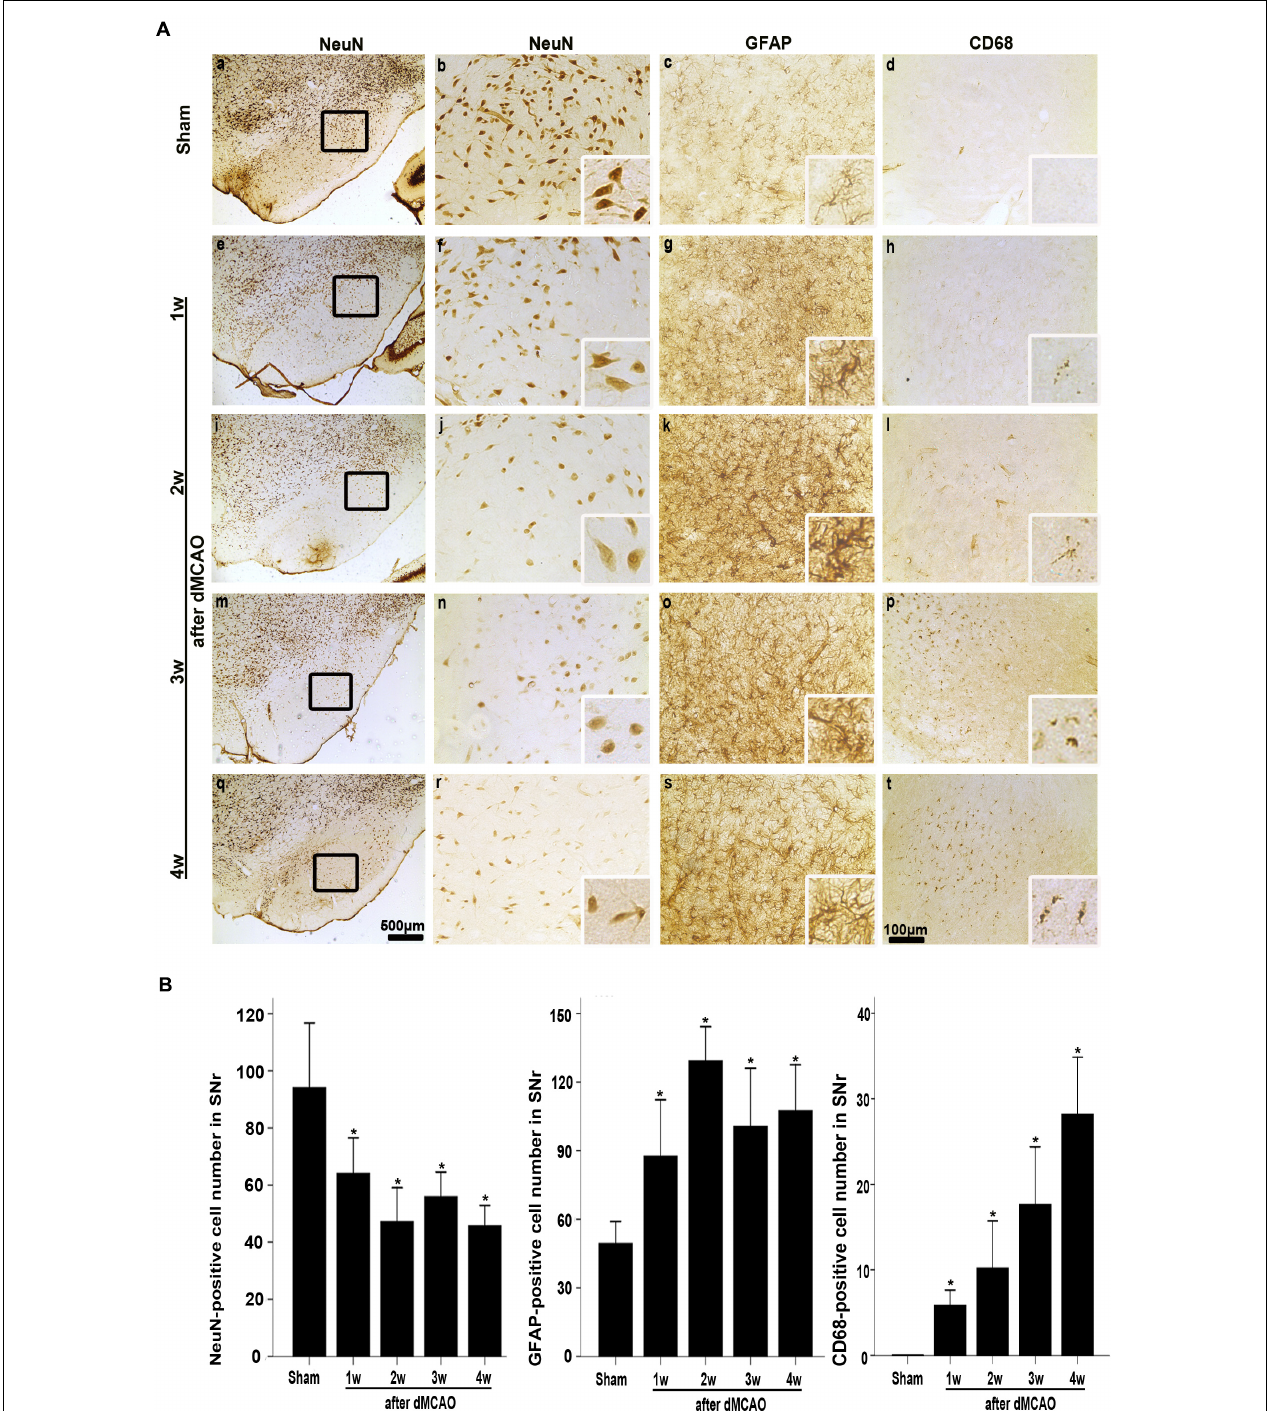
FIGURE 3 | Secondary degeneration in the ipsilateral SNr after dMCAO in rats. (A) Representative microphotographs of immunostaining of NeuN, GFAP, and CD68 in the ipsilateral SNr at 1–4 weeks after dMCAO or sham operation. a–d , sham-operated group; e–h , 1 week after dMCAO; i–l , 2 weeks after dMCAO; m–p , 3 weeks after dMCAO; q–t , 4 weeks after dMCAO; Scale bar: b–d , f–h , j–l , n–p , r–t : 100 µ m; a , e , i , m , q : 500 µ m. (B) Quantitative analysis of NeuN-positive cells ( n = 6 in sham-opreated group, n = 6, 6, 6, and 7 at 1–4 weeks after dMCAO, respectively), GFAP-positive cells ( n = 6 in each group) and CD68-positive cells ( n = 7 in sham-opreated group, n = 6, 7, 6, 6 at 1–4 weeks after dMCAO, respectively) in the ipsilateral SNr. Each bar represents the mean ± SD. ∗ p < 0.05 versus sham-operated group. NeuN, neuron-specific nuclear-binding protein; GFAP, glial fibrillary acidic protein; CD68, cluster of differentiation 68; Sham, sham-operated; w,